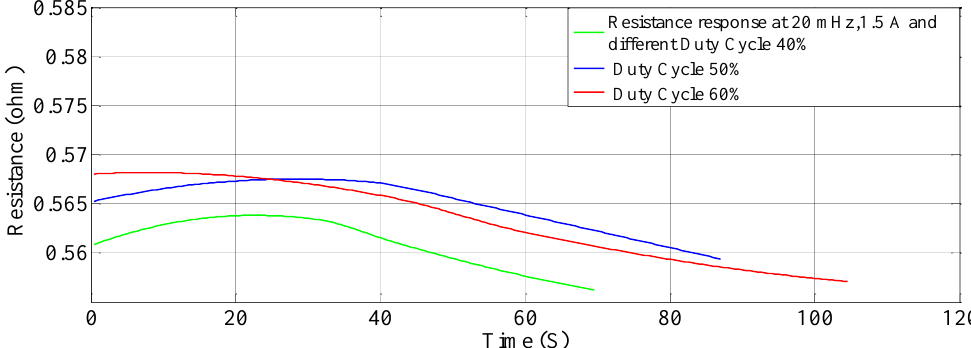
Figure 16. Resistance response at different duty cycles.